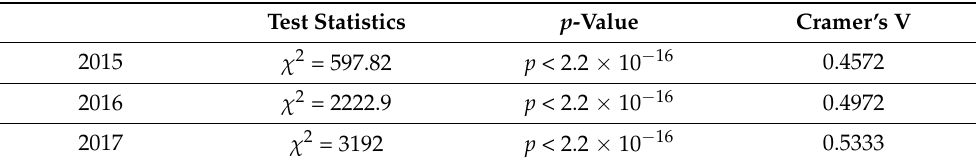
Table 8. Test results: The relationship between gender and the college. Test Statistics